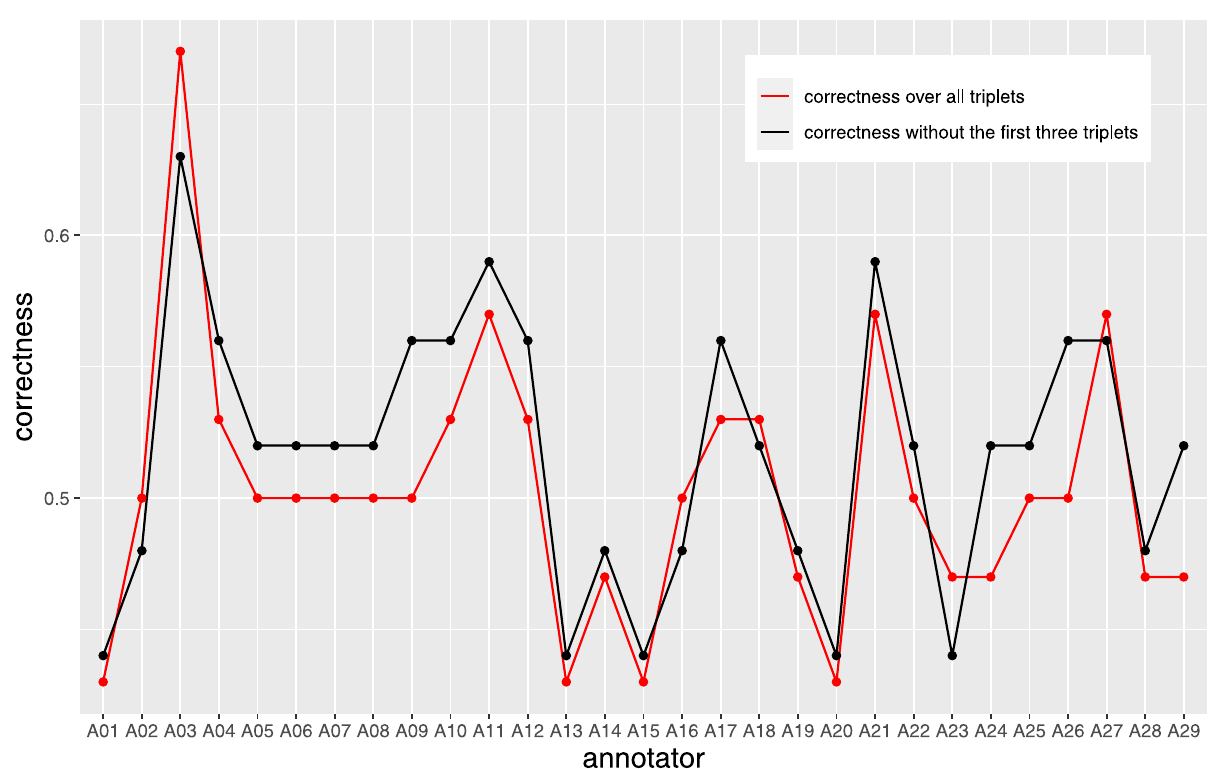
Fig 3. A_CorrectnessRatio for the 29 non-expert annotators, when all triplets are considered (red line) and when the first three are removed (black line). Although a slight improvement can be perceived for most of the annotators, the difference is very small, implying that the acclimatization phase has almost no effect on correctness.